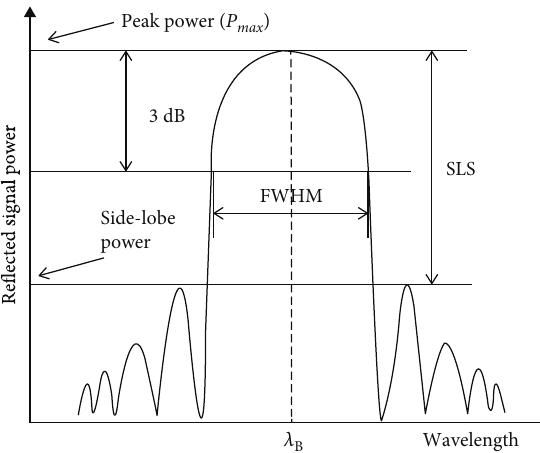
Figure 2: Typical re fl ected optical spectrum and main parameters of the FBG signal